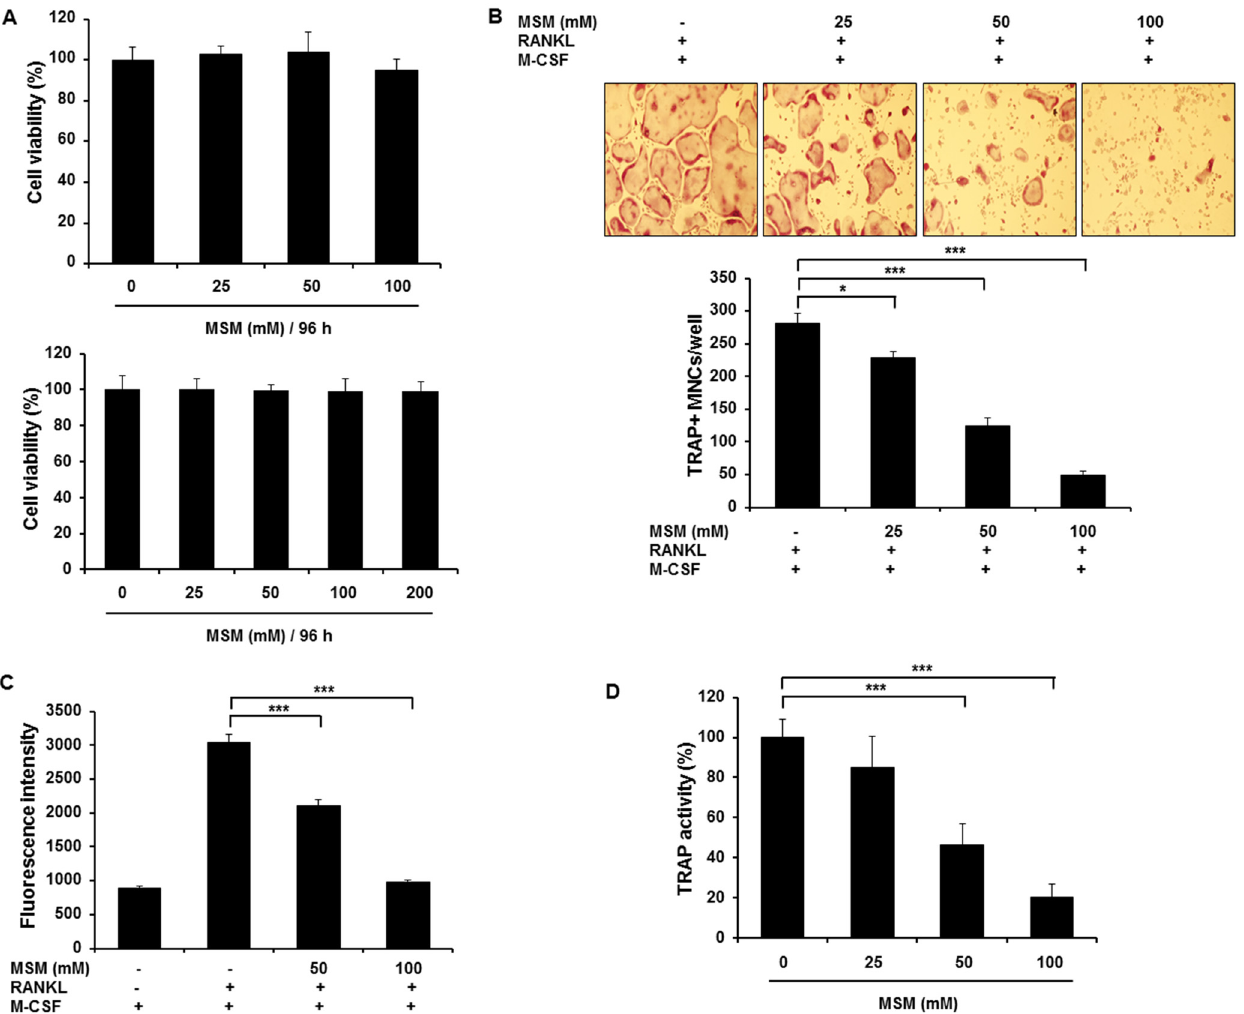
Fig 1. MSM suppresses RANKL-induced osteoclastogenesis in BMMs. BMMs were cultured in the presence of M-CSF (30 ng/ml) and RANKL (100 ng/ml) for 4 days with or without MSM as indicated. (A) Cell viability was evaluated by MTT and Alamar blue assay. (B) TRAP staining with light microscopy enabled TRAP-positive multinucleated cells (MNCs were categorized as containing (cid:2) 3 nuclei) to be quantified. (C) Quantitative assessment of TRAP activity. (D) Bone resorption activity was evaluated by fluorescence intensity. Data shown are representative of three independent experiments. Asterisks indicate a significant increase by ANOVA ( * p < 0.05, *** p < 0.001).